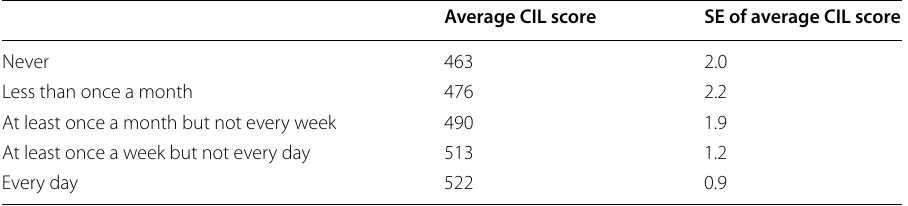
Table 1 Frequencies of ICT use for communicating with others using messaging or social networks (cross-country average) and CIL score Average CIL score SE of average CIL score Never 463